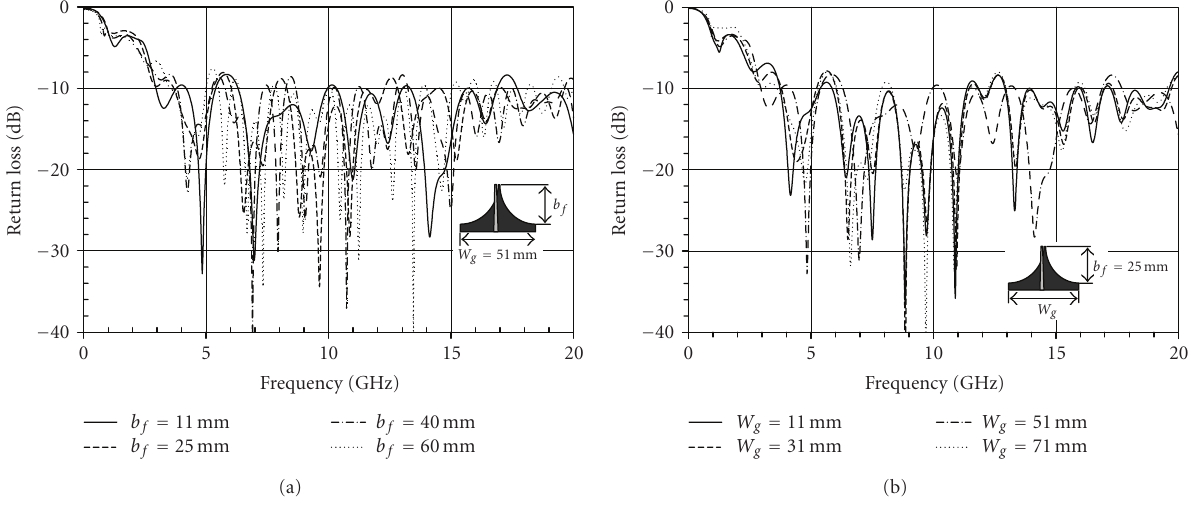
Figure 5: Return loss for di ff erent feeding transition configuration.